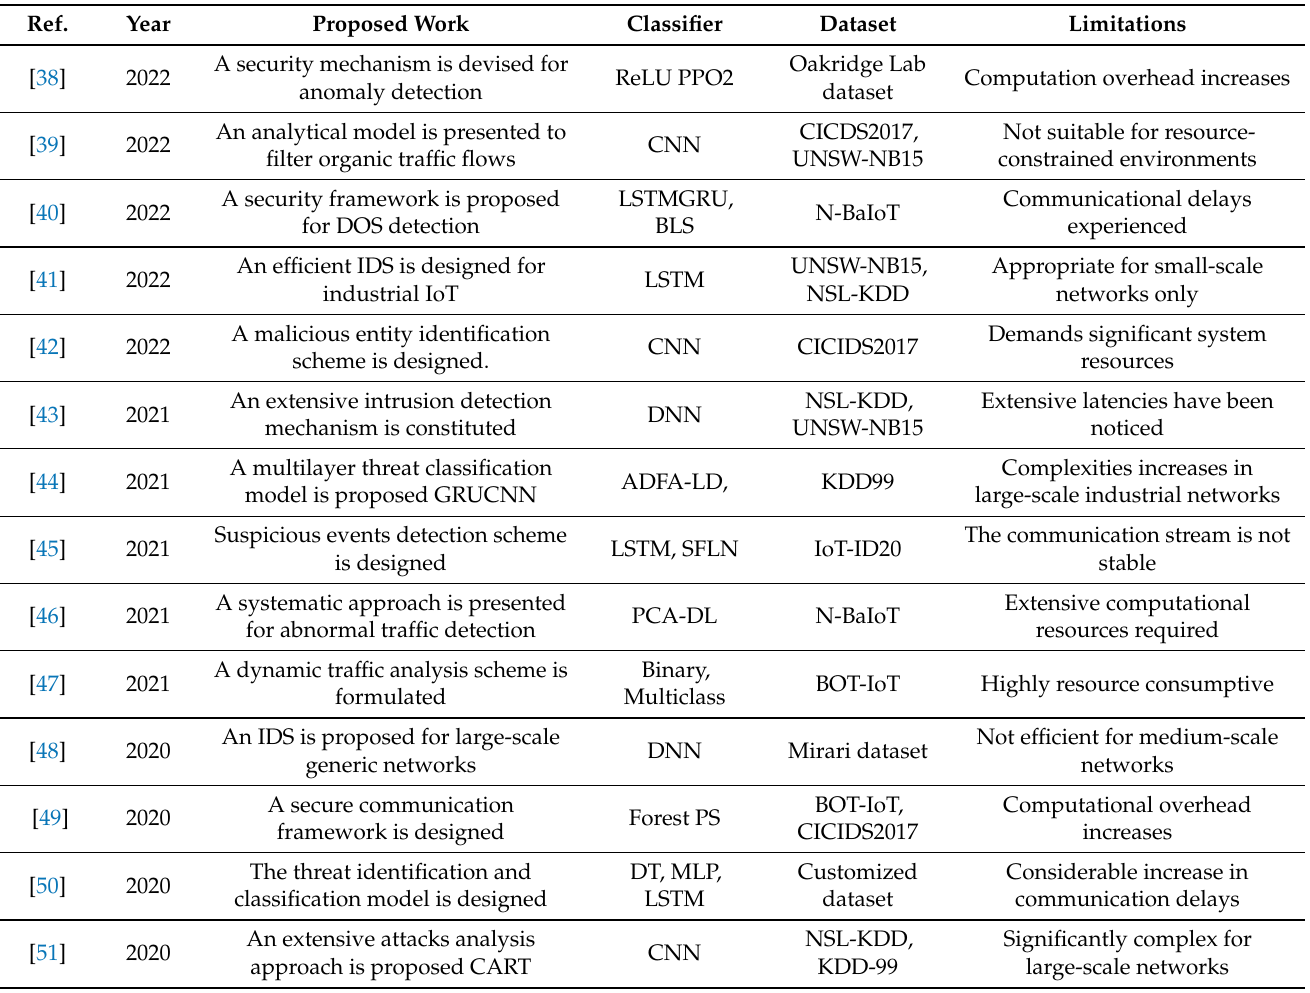
Table 1. Existing